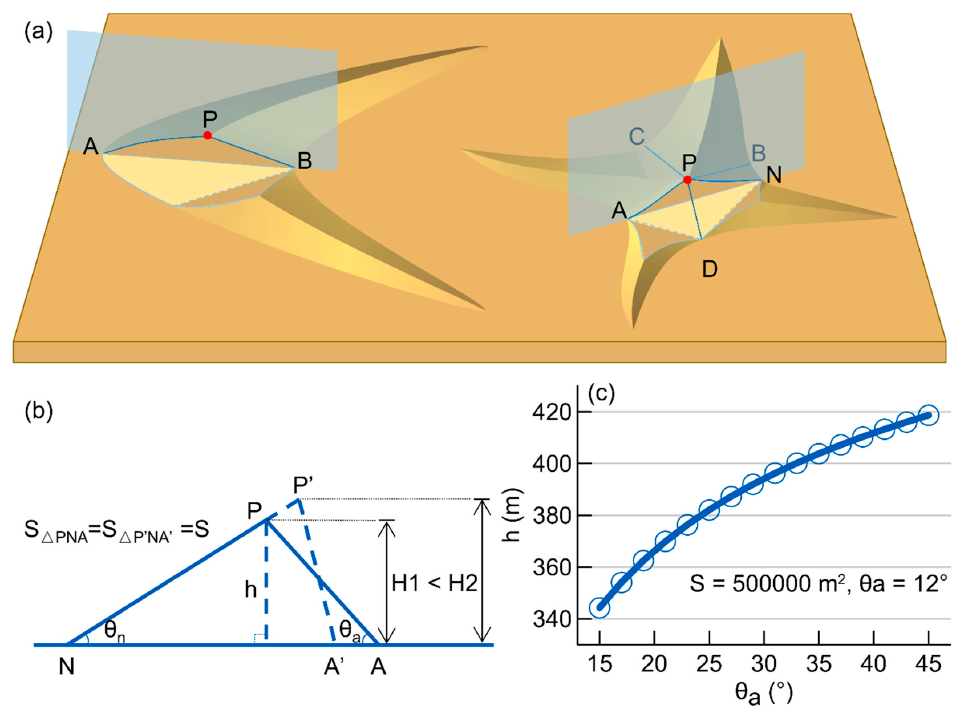
Figure 10. ( a ) Sketch of the relationship between the dune height and dune slope. ( b ) Line chart of θ a and h incorporating the area of the triangle (referring to the dune volume) and assuming that S = 500,000 and that θ n = 12°. ( c ) Sketch showing that the peak point of a dune (point P) is maintained by several slope faces, which are described by the maximum slope lines (PA, PB, PC, and PD). Among these slope line relationships, PN is coplanar with PA and plane PAN is perpendicular to the ground plane.